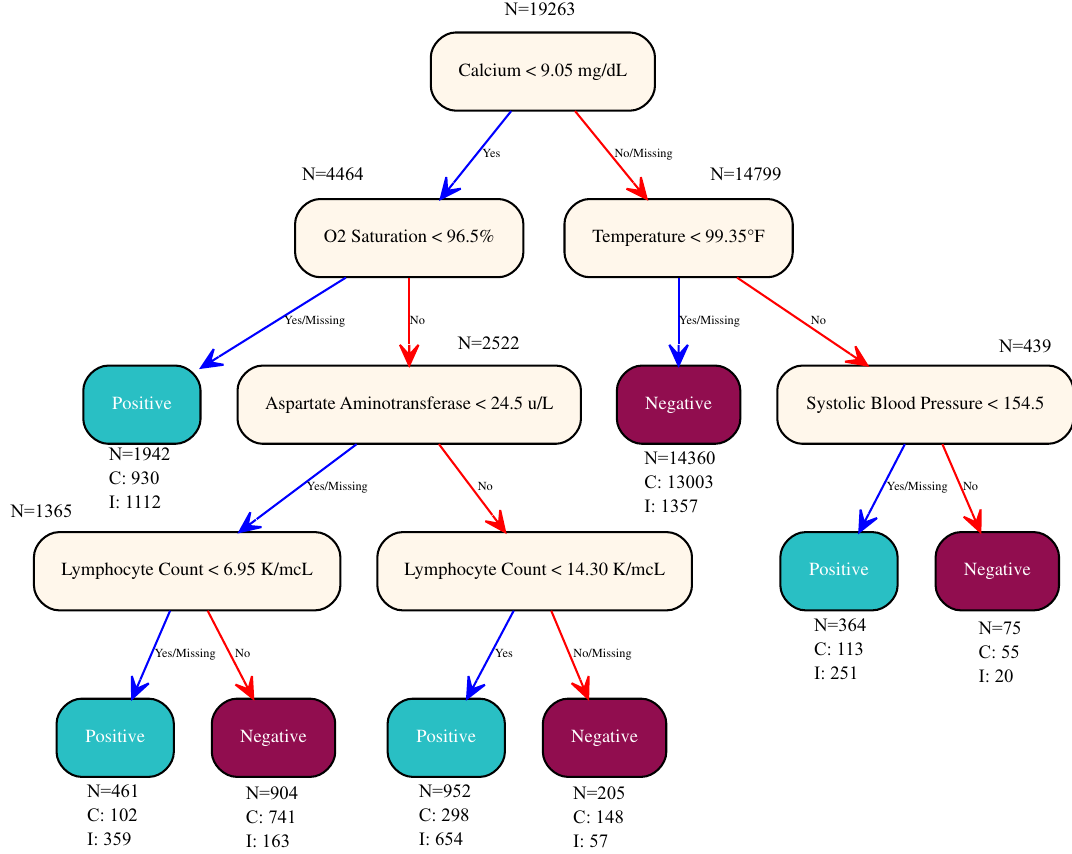
Figure 4. A clinically applicable decision algorithm used by the single-tree XGBoost model. N = number of patients in a class; C = number of patients correctly classified; I = number of patients incorrectly